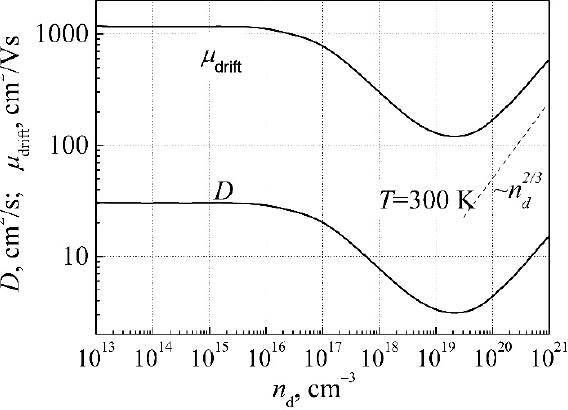
Figure 8. Comparison of the diffusion coefficient and the drift mobility of the free RM electrons as a function of the phosphorous doping level in silicon at room temperature.